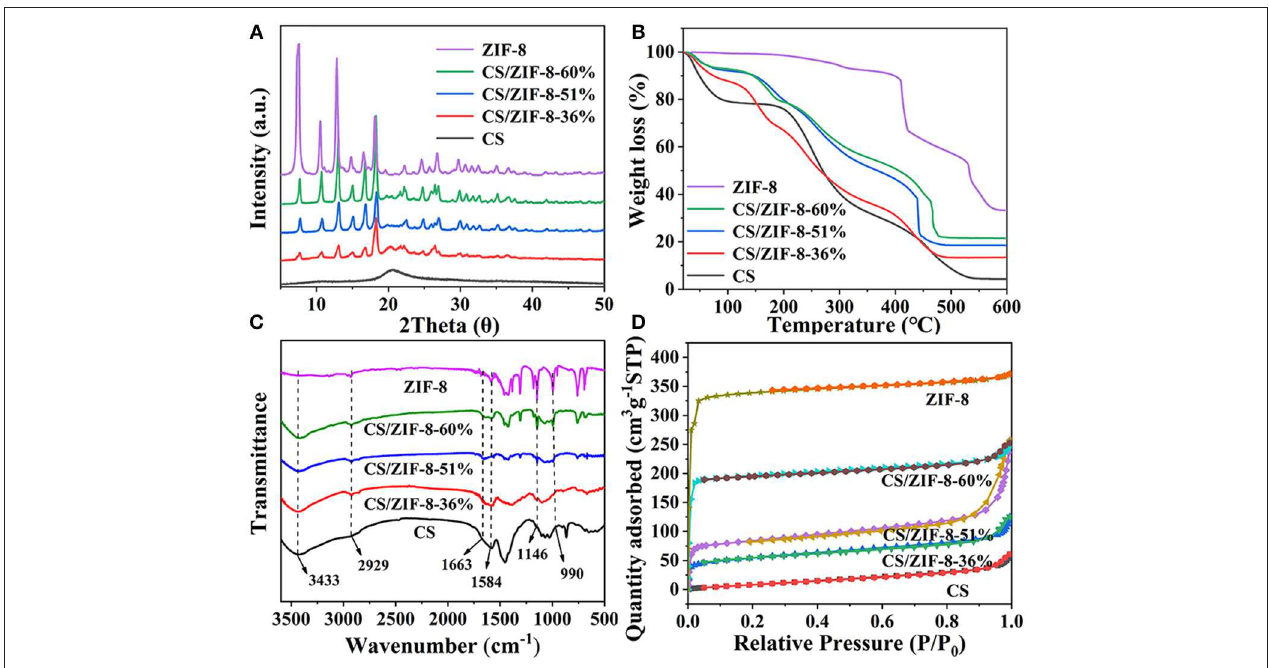
FIGURE 3 | (A) PXRD patterns, (B) TG curves, (C) FT-IR spectra, (D) Nitrogen adsorption/desorption isotherms of CS, ZIF-8, CS/ZIF-8–36%, CS/ZIF-8–51%,